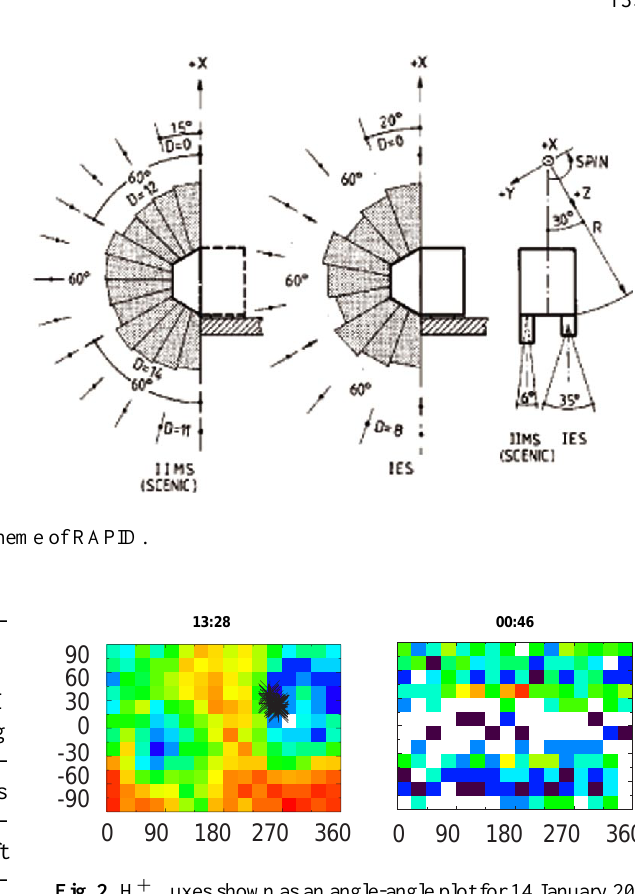
Fig. 2. H + fluxes shown as an angle-angle plot for 14 January 2001 and 3 March